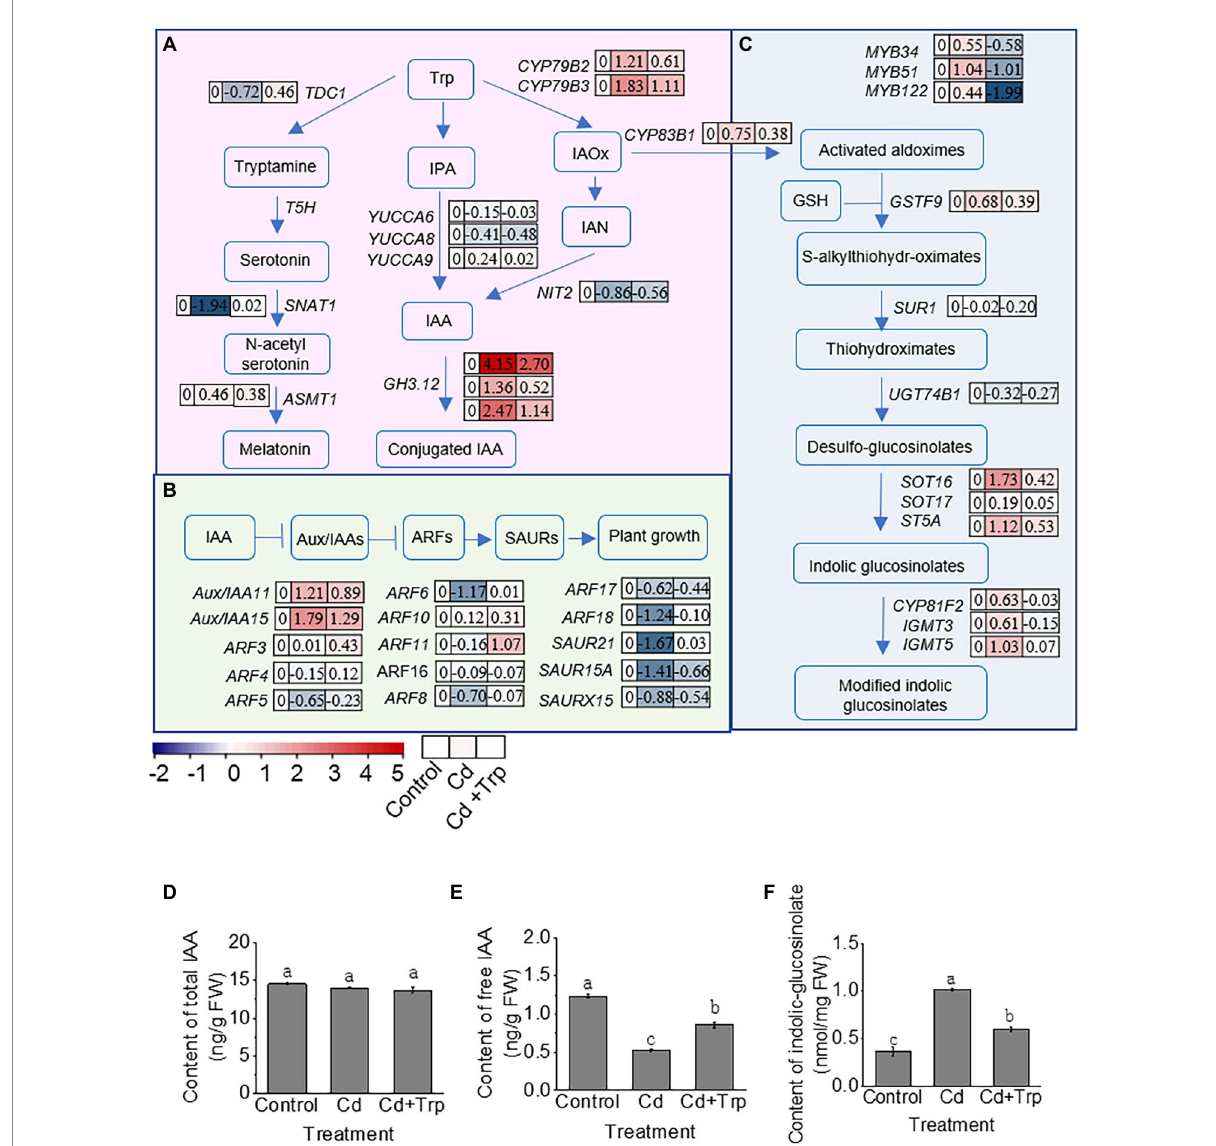
FIGURE 6 Effect of Trp on its downstream metabolic pathways under Cd stress. (A) Schematic diagram of metabolic pathway of IAA and melatonin. (B) Schematic diagram of signaling pathway of IAA. (C) Schematic diagram of biosynthesis of indolic glucosinolates. MYB51, MYB34, and MYB122 are transcription factors that activate the expression of genes in indolic glucosinolates biosynthesis. Heat map of the expression profiles is shown next to the name of the genes. Values indicate log 2 of the gene transcript levels under Cd stress with or without Trp application versus that of control. (D) Total IAA content. (E) Free IAA content. (F) Indolic glucosinolates content. Trp, tryptophan; IPA, indole-3-pyruvic acid; IAOx, indole-3- acetaldoxime; IAN, indole-3-acetonitrile; IAA, indole-3-acetic acid; Aux/IAA, Aux/IAA family; ARF, auxin response factor; SAUR, small auxin up RNA. FW, fresh weight. Data were averaged from three independent replicates ±